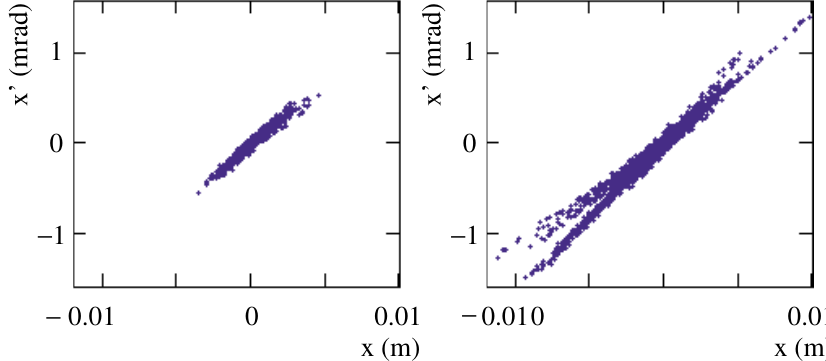
FIG. 10. (Color) Horizontal phase space at the extraction point after five turns. The left plot corresponds to the case of a perfectly uniform kick at injection; the right plot is obtained when using rf deflectors for a bunch combination factor of 5.